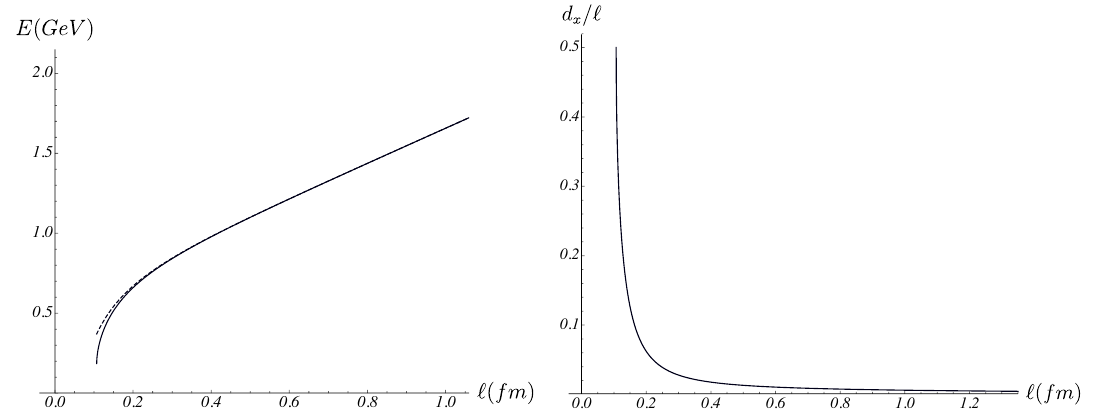
(dashed curve) vs ‘ . Right: ratio d x /‘ vs ‘ . Q ¯ Q